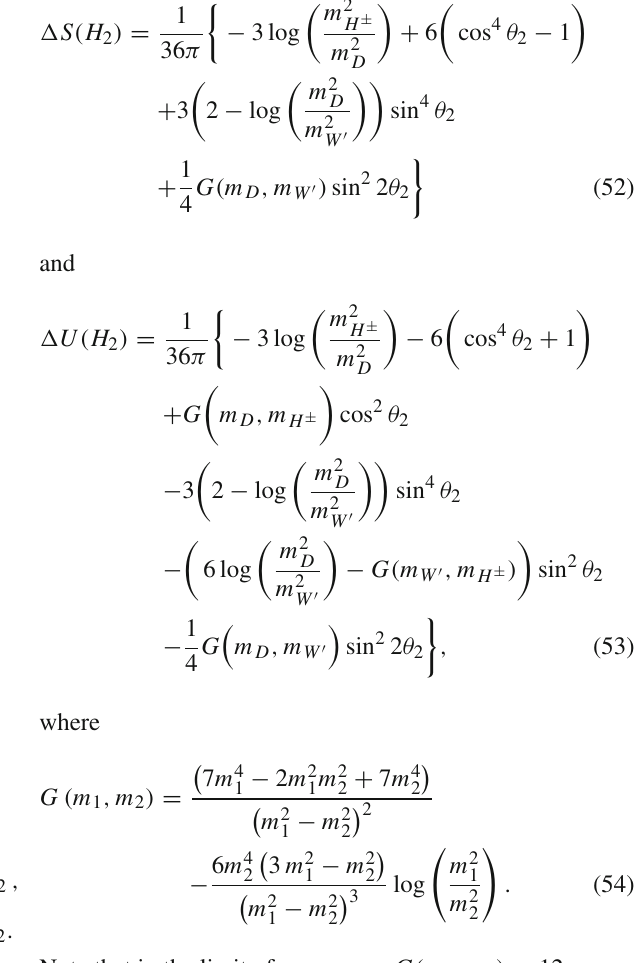
contribution is constrained to be relatively small in both cases andthusmakesitdifficultforthehidden SU ( 2 ) H doublet (cid:4) H to explain the CDF W boson mass